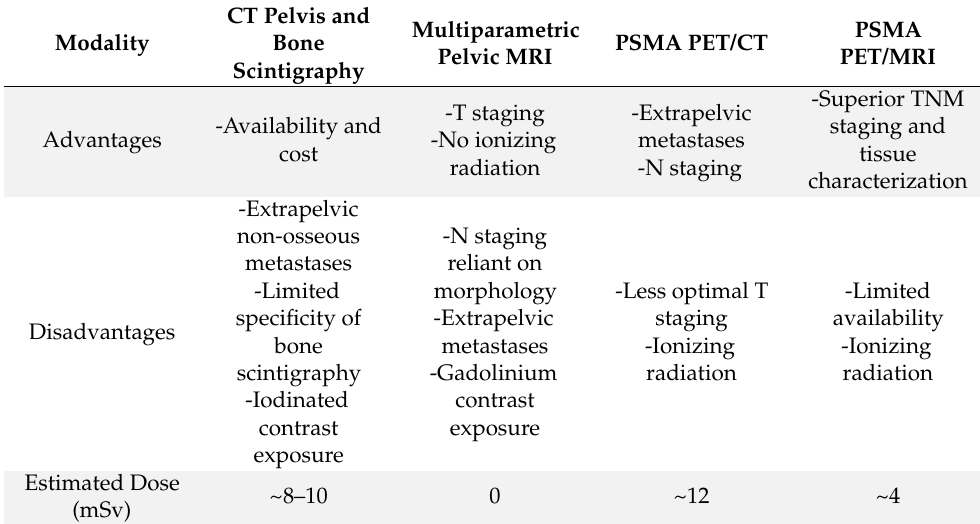
Table 4. Advantages and disadvantages of initial staging